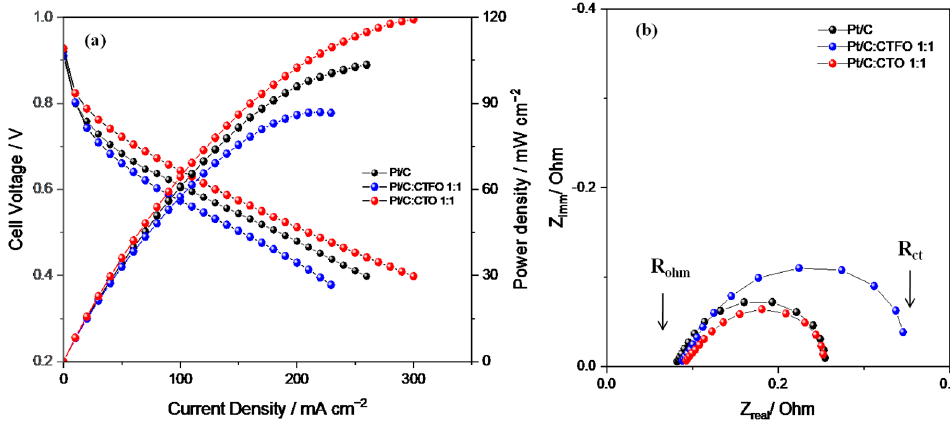
Figure 9. ( a ) Fuel cell performances and ( b ) impedance spectra recorded at 0.6 V in the frequency range of 10 kHz–1 Hz, under 80% RH and at 80 °C.